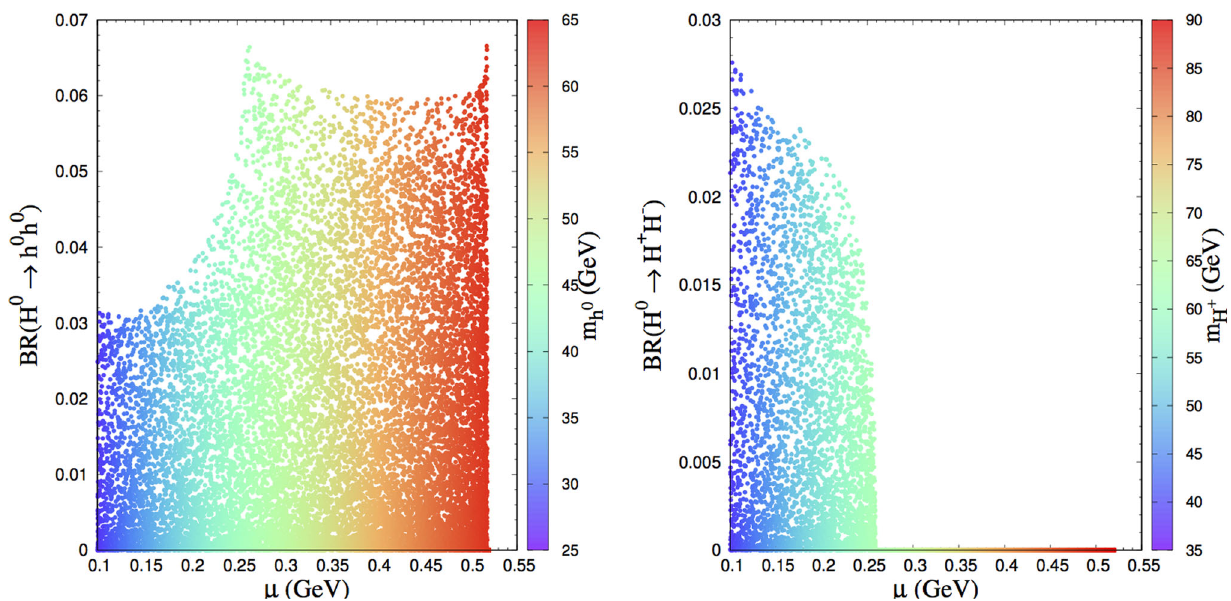
Fig. 8 The branching ratios for H 0 → h 0 h 0 (left) and H 0 → H ± H ∓ (right) as a function of μ . The Higgs masses, m h 0 and m H ± , are considered in the ranges represented by the color codes. Our inputs are: λ ≈ 0 . 52, 10 − 2 ≤ μ ≤ 0 . 55 (GeV), m H 0 ≈ 125 GeV, | λ a | ≤ 1 . 5, λ b = 1, and v t = 1 (GeV) Fig. 9 (Left): R γγ ( H 0 ) as a function of m H ± for various values of λ a . (Right): correlation between R γγ ( H 0 ) and R γ Z ( H 0 ) for various of λ a